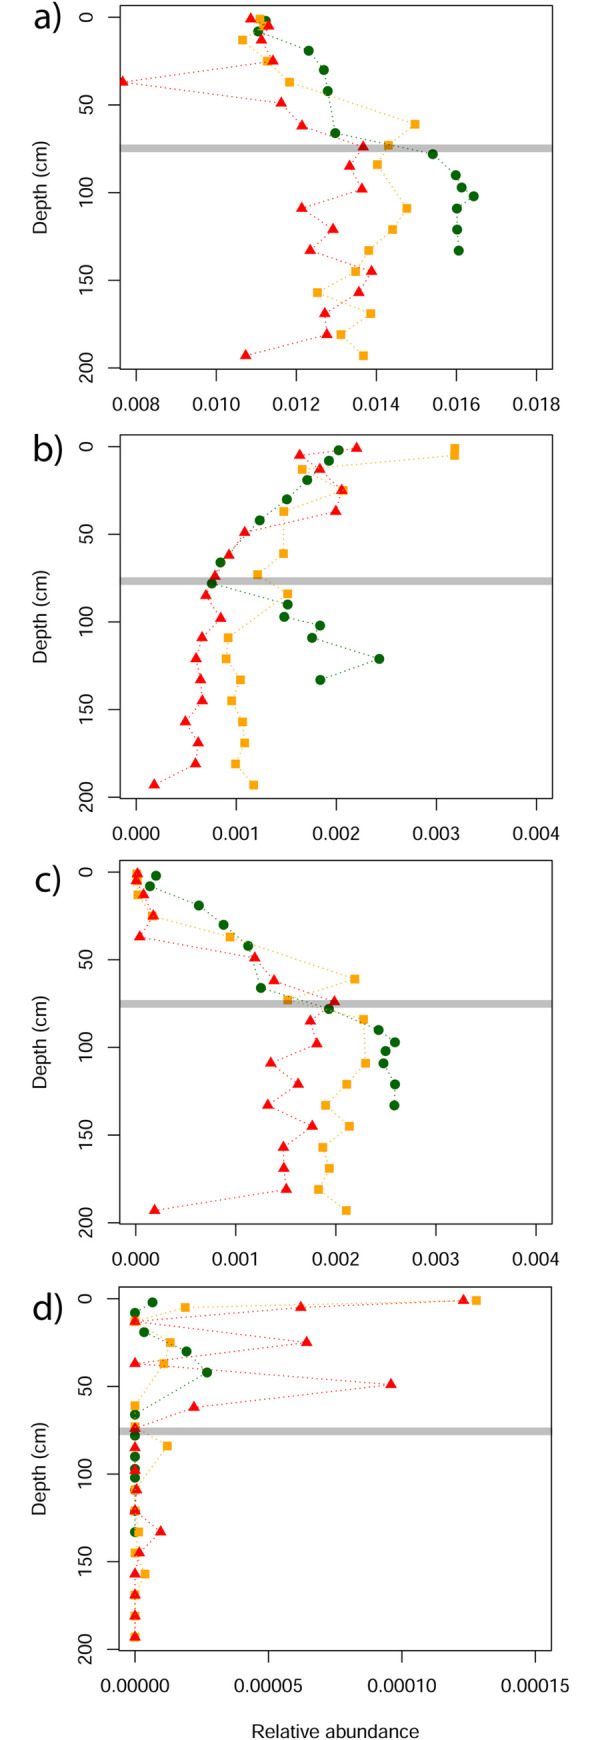
Differences in the relative abundance of metabolic pathways related to the carbon cycle in three New Zealand ombrotrophic bogs along a wetland condition gradient.a) carbon fixation; b) fermentation; c) methanogenesis; d) methanol to CO2. Red, Dunearn (most modified condition); Orange, Bayswater (moderate condition); Green, Awarua (most intact condition). Horizontal line marks 75 cm depth.